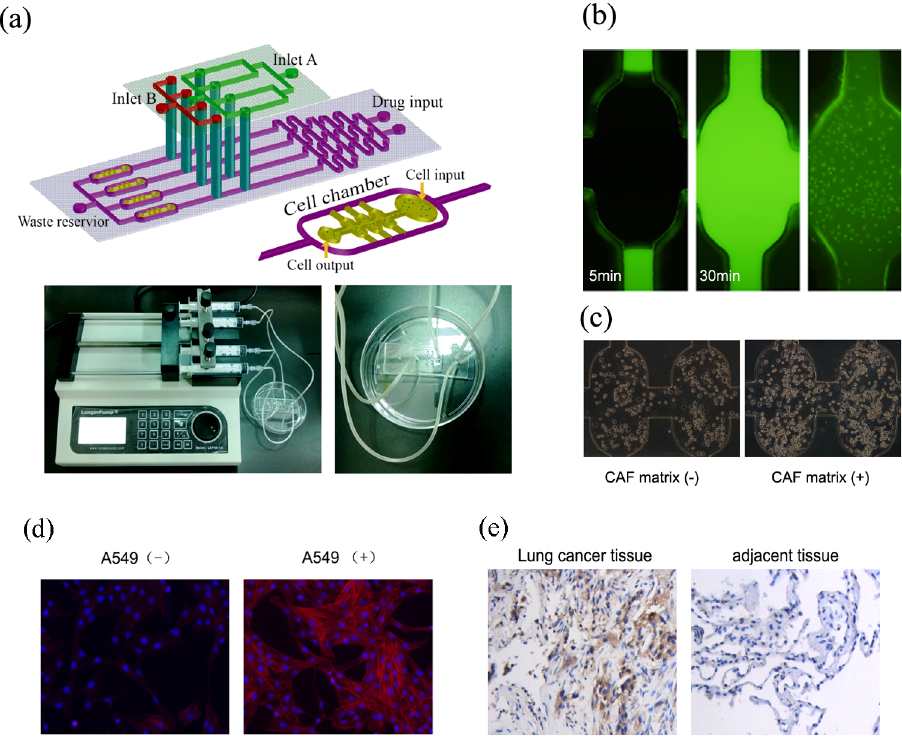
Fig 1. The design and validation of a 3D culture microfluidic chip. (a)The schematic design of the microfluidic chip with CGG and downstream cell chambers (the upper panel) and the fabricated chip with pumping machine (the lower panel). (b)The diffused Rh-123 in the 3D chamber within 30 min and > 95% cells were viable (green). Magnification ×100. (c) The morphological features of A549 cells in the 3D chamber without or with CAF matrix. The white arrows indicate apoptotic cells. (d)The α -SMA immunofluorescence assay of HFL1 cells. HFL1 cells induced by A549 medium showed a positive α -SMA staining (right) compared to the untreated HFL1 (left). Magnification ×400. (e) Immunohistochemistry assay for lung cancer tissues. The expression of α -SMA protein in the lung cancer tissues is higher than that in adjacent tissues. Magnification